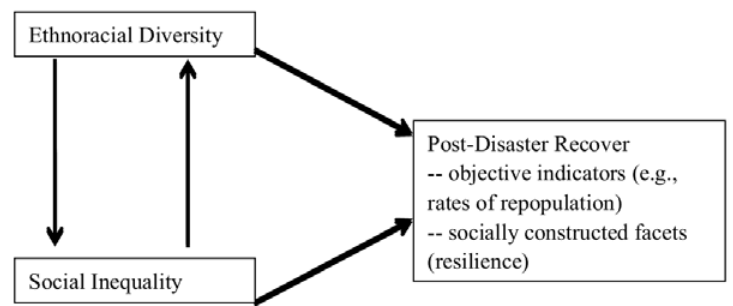
Figure 1. Conceptual and Analytical